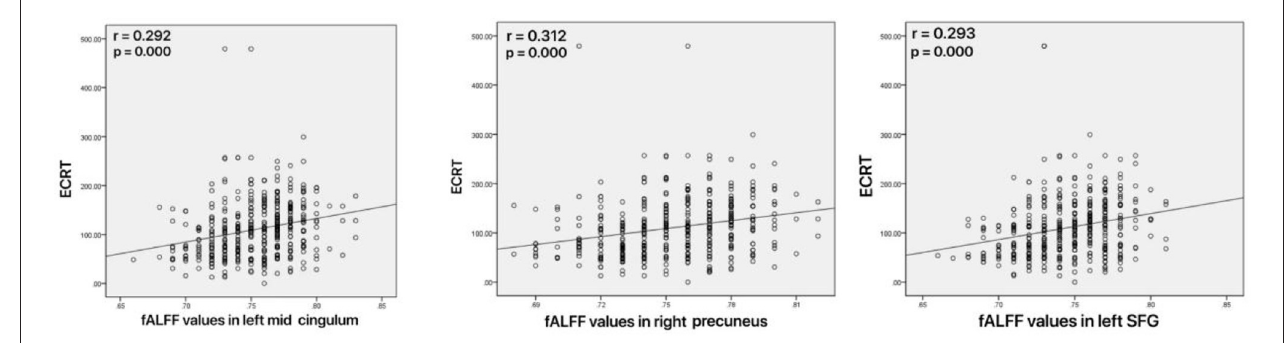
FIGURE 4 | Correlations between abnormal fractional amplitude of low-frequency fluctuation (fALFF) and executive control reaction time (ECRT). Left: Positive correlation between the fALFF values in the left mid cingulum and ECRT; Mid: Positive correlation between the fALFF values in the right precuneus and ECRT; Right: Positive correlation between the fALFF values in the left SFG and ECRT.